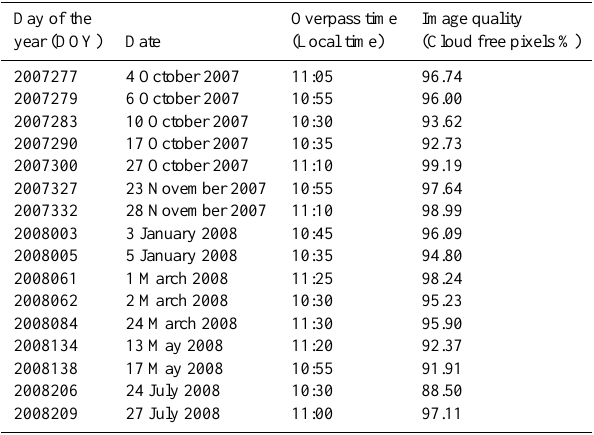
Table 2. Day of year, date, overpass time and image quality for the study